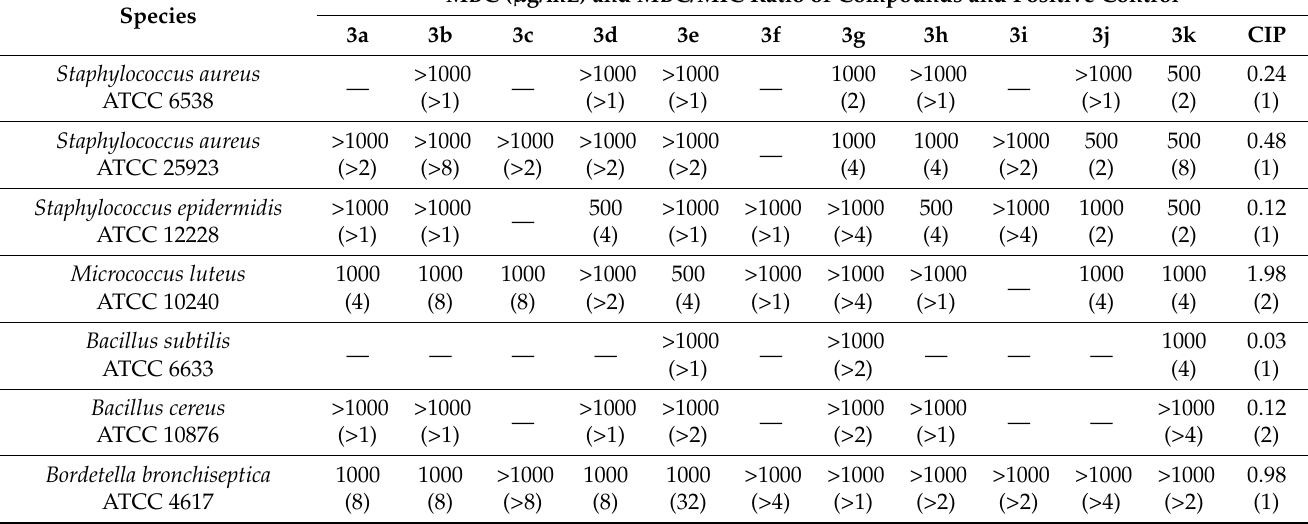
Table 2. The activity data of compounds expressed as MBC ( µ g/mL) and MBC/MIC ratio against the reference strains of bacteria. The standard antibiotic—ciprofloxacin (CIP) was used